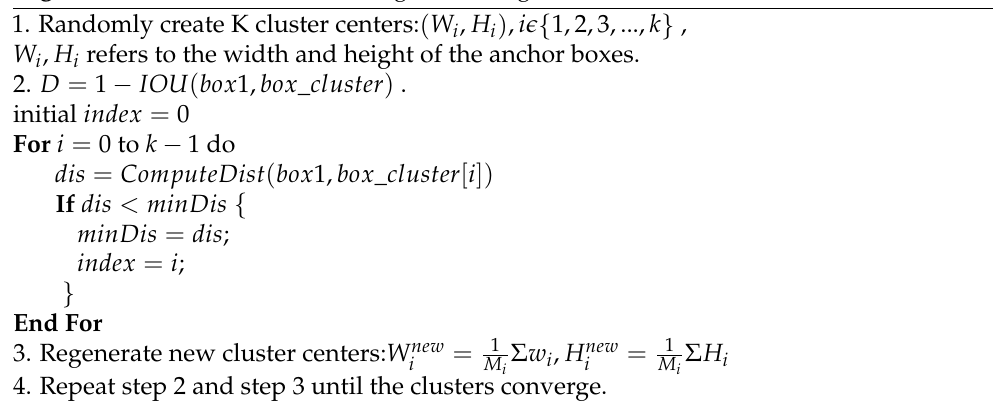
Algorithm 1 Pseudocode for the algorithm to generate the new anchor boxes.